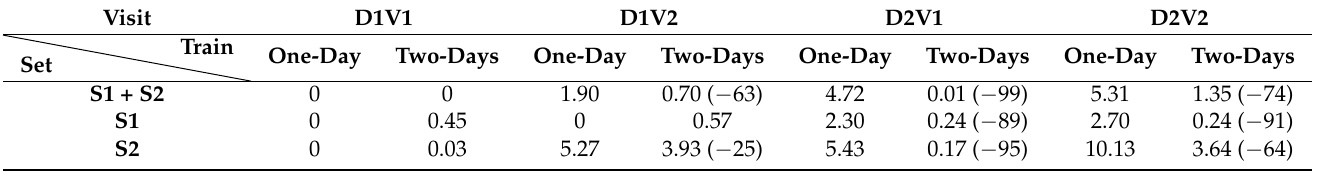
Table 8. EER (%) results for the final selected hyperparameters, with the different datasets (S1, S2, and S1 + S2) with one-day and two-days data in training. The EER variation between one-day and two-days is detailed as a percentage (%) in parenthesis when both data are